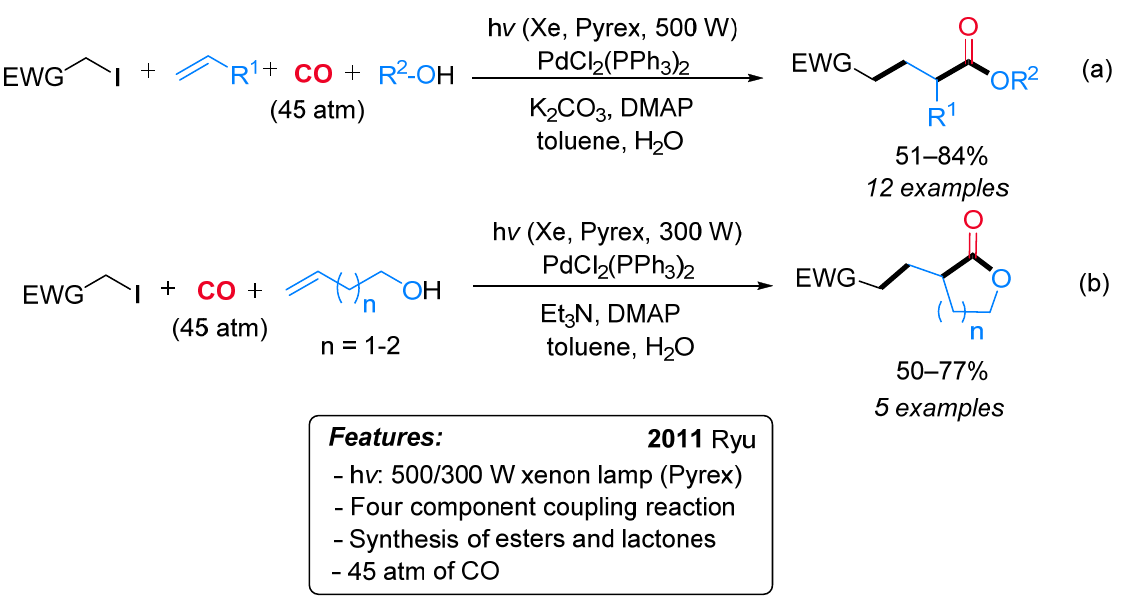
Scheme 7. Pd-catalyzed/Light-induced four and three-component coupling reactions to esters ( a ) and lactones ( b